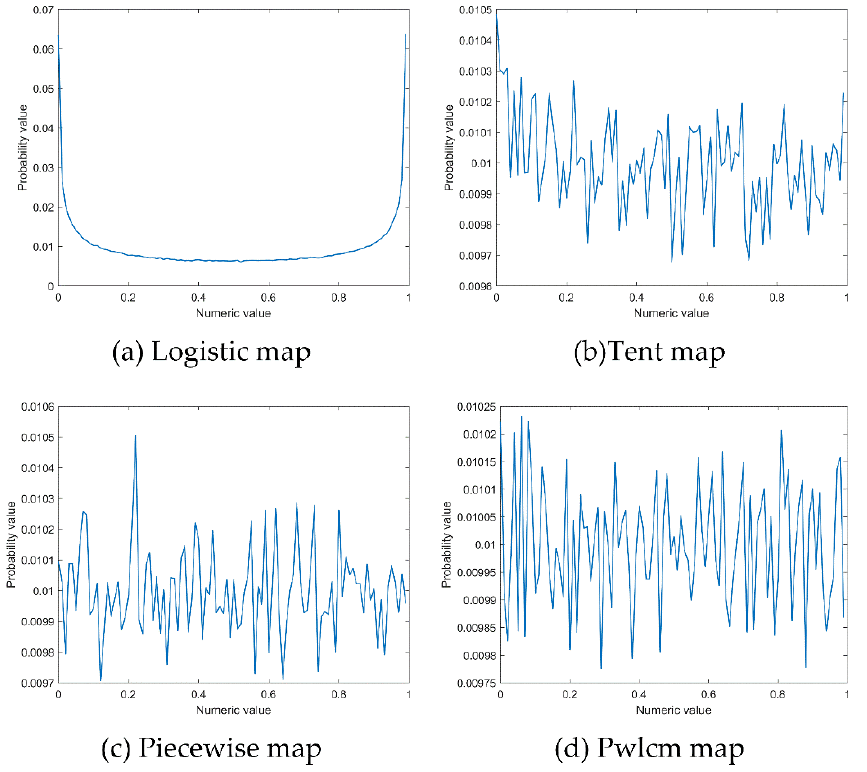
Figure 7. Probability distribution of four typical chaotic maps.